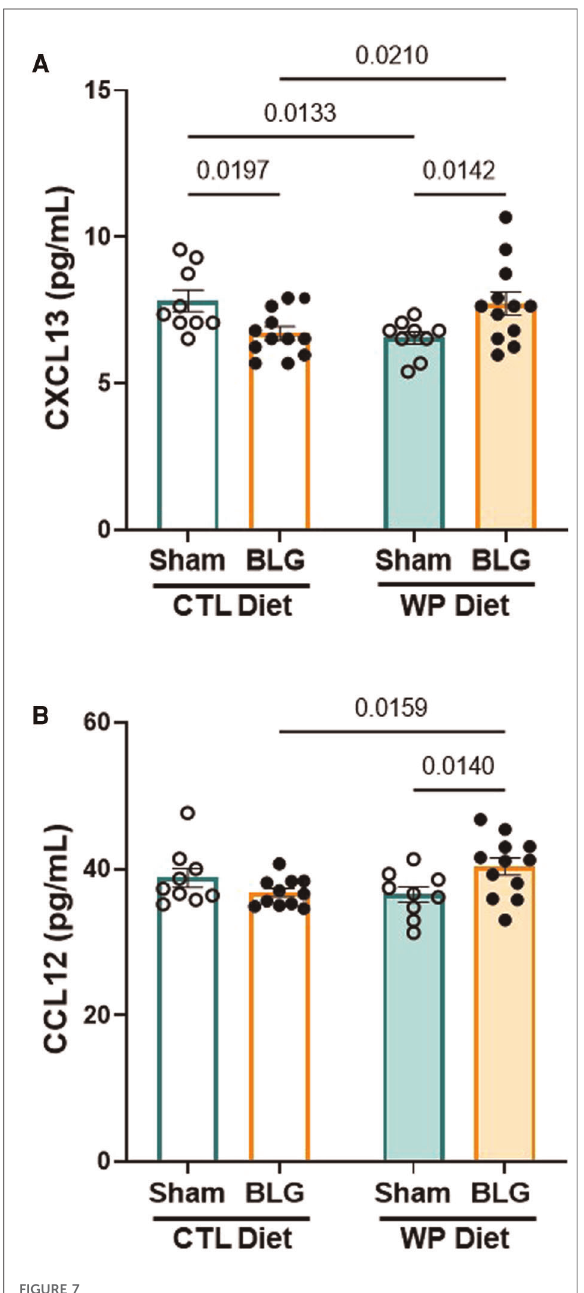
FIGURE 7 Chemokine levels in the hippocampal region. The hippocampus dissected from the right brain hemisphere of each mouse was lysed to extract total proteins. Ten µg of the hippocampal lysates were used to quantify CXCL13 ( A ) and CCL12 ( B ) using ELISA. The concentrations of the analytes were determined from respective standard curves. Values indicate the group average±SEM. Signi fi cant p -values are shown. Two-way ANOVA, n =9 – 12 per